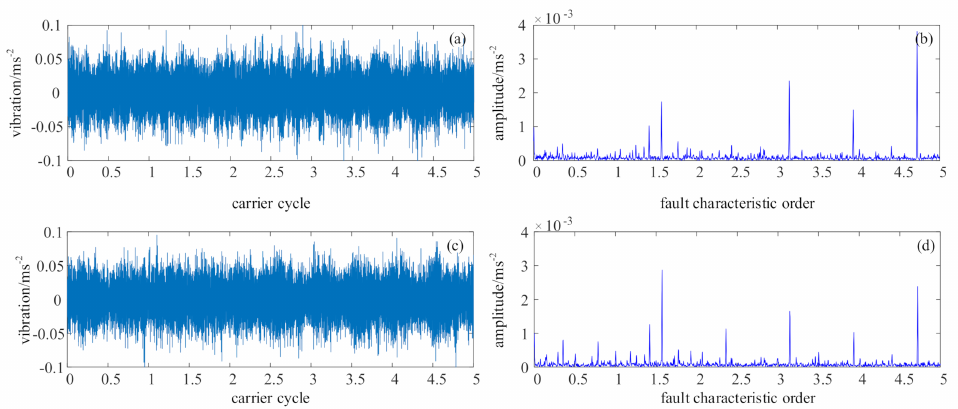
Figure 20. Raw signal: ( a ) health condition waveform, ( b ) health condition envelope order spectrum, ( c ) fault condition waveform, and ( d ) fault condition envelope order